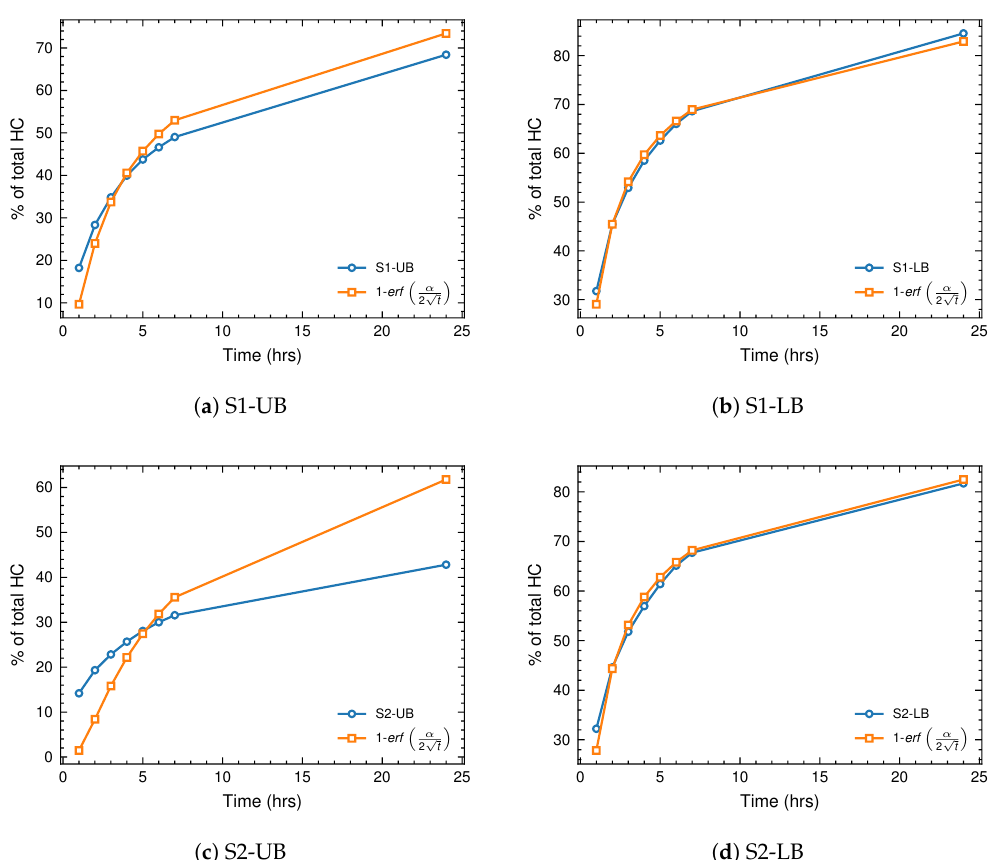
Figure 12. A comparison of the cumulative recovery factor profiles vs. the predicted profiles using Equation